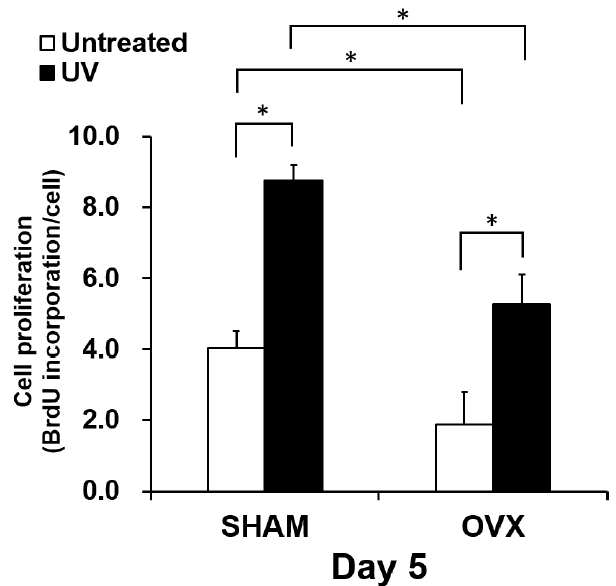
Figure 4. Proliferative activity of osteoblasts from sham and OVX groups on untreated and photofunctionalized titanium surfaces. 5-Bromo-2 ′ deoxyuridine (BrdU) incorporation into DNA during mitosis standardized by cell number. BrdU incorporation into DNA measured on day 5. Each value represents the mean ± standard deviation from triplicate experiments ( n = 3). * p < 0.05, significant difference between untreated and photofunctionalized surfaces.